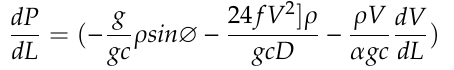
Figure 5. Cross-section of the dual strings well.